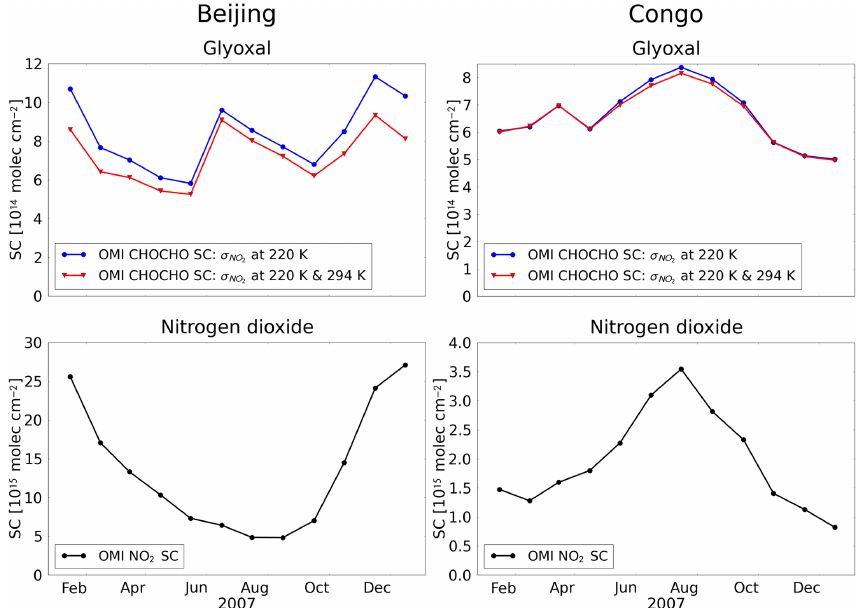
Figure 6. Seasonal variation of glyoxal SCs including and excluding the high-temperature NO 2 absorption cross-section (top), and NO 2 SCs (bottom) over Beijing (left: latitude, 37 . 5 ◦ ± 2 . 5 ◦ ; longitude, 115 . 5 ◦ ± 1 . 5 ◦ ) and Congo (right: latitude, − 4 . 0 ◦ ± 2 . 0 ◦ ; longitude, 18 . 0 ◦ ± 2 . 0 ◦ ) for 2007. Table 2. Chi-square relative difference and P values from the Wilcoxon signed-rank test for five regions have been computed, using as reference water vapour cross-section the one from the HITRAN–2005 database (Rothman et al., 2005). Rel. diff.